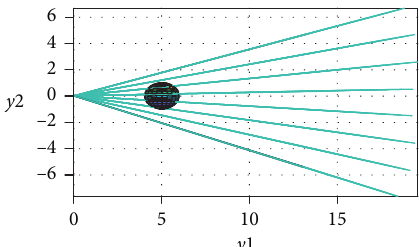
Figure 4: Vertical projection of the 3D lidar’s view for one obstacle in 5 m.